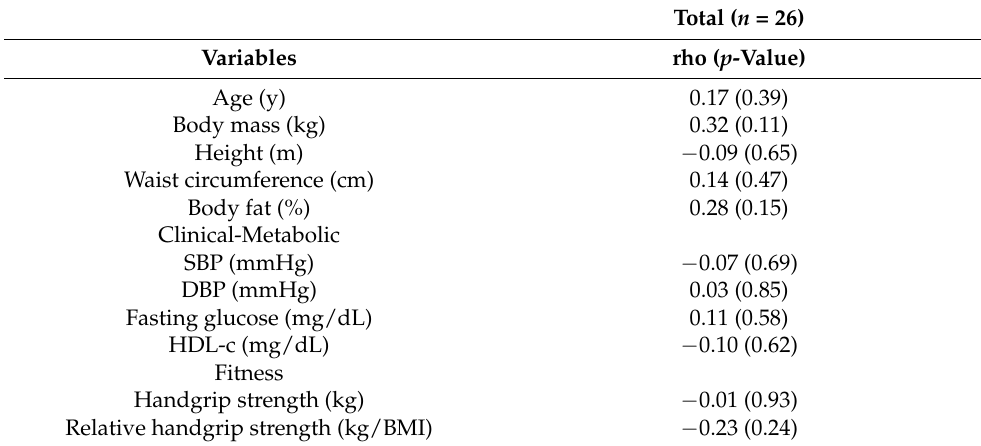
Table 2. Relationship between sleep quality score and anthropometric, metabolic and fitness parameters.